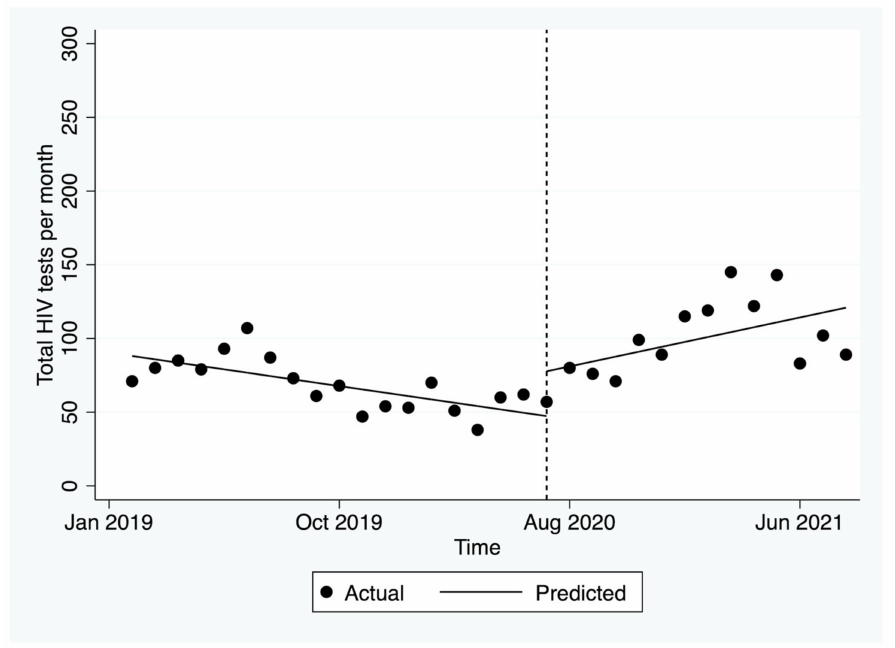
Figure 4. Number of tests for HIV before and after the hub-and-spoke